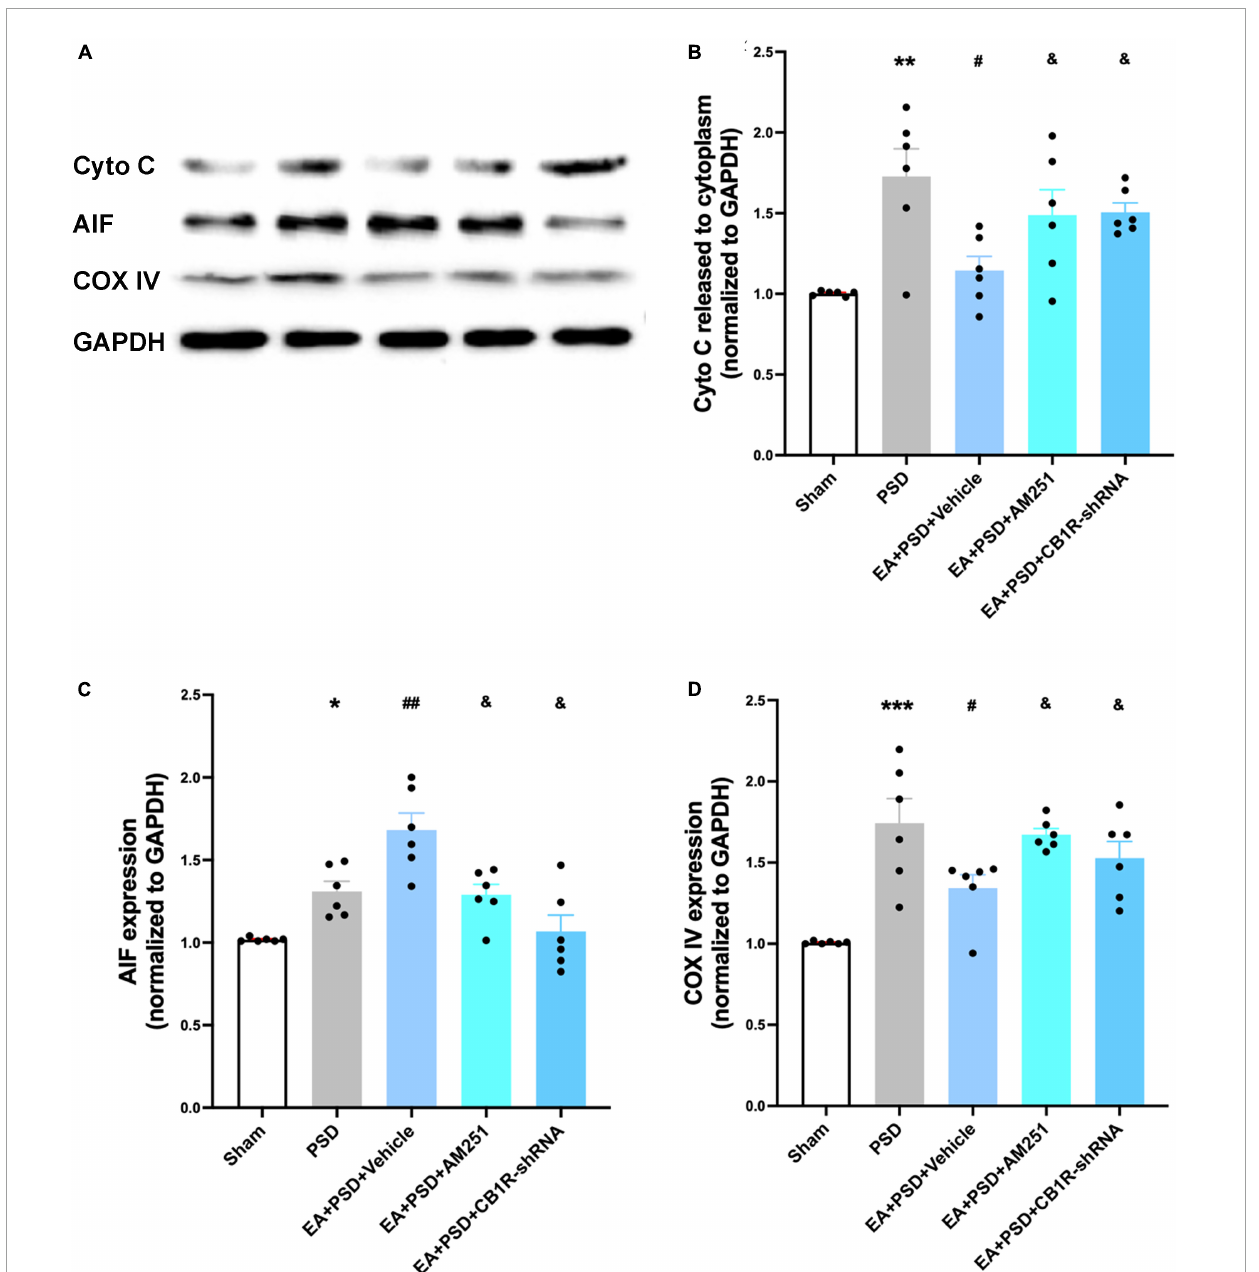
FIGURE8 Supplementation with AM251 or CB1R-shRNA reversed the improved mitochondrial function mediated by EA treatment. (A) Representative images of western blots of the cytochrome C, AIF and COX ? proteins. (B,D) Quantitative changes in cytochrome C (B) , AIF (C) and COX IV (D) and in the in the hippocampus ( n = 6, * P < 0.05, ** P < 0.01, and *** P < 0.01 vs. the sham group, # P < 0.05, ## P < 0.01 vs. the PSD group, & P < 0.05 vs. the EA